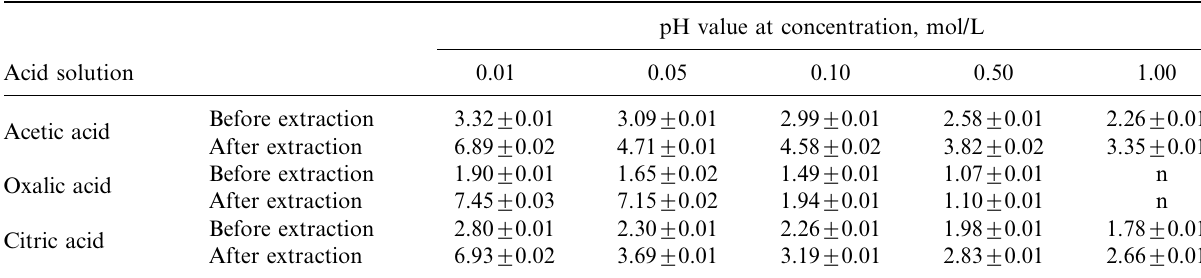
pH value at concentration, mol/L